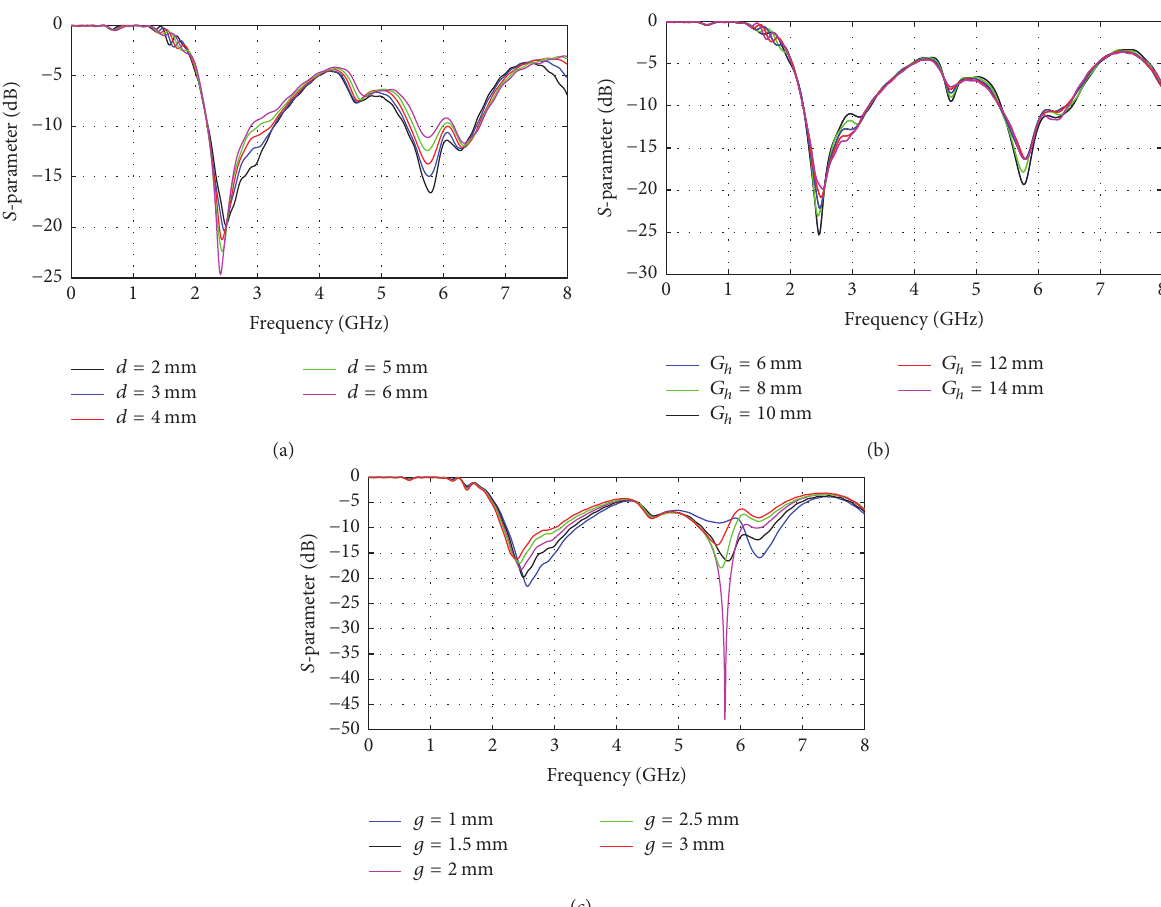
Figure 4: Optimized return loss of antenna array: (a) 𝑆 11 for different 𝑑 ; (b) 𝑆 11 for different 𝐺 ℎ ; (c) 𝑆 11 for different 𝑔 .